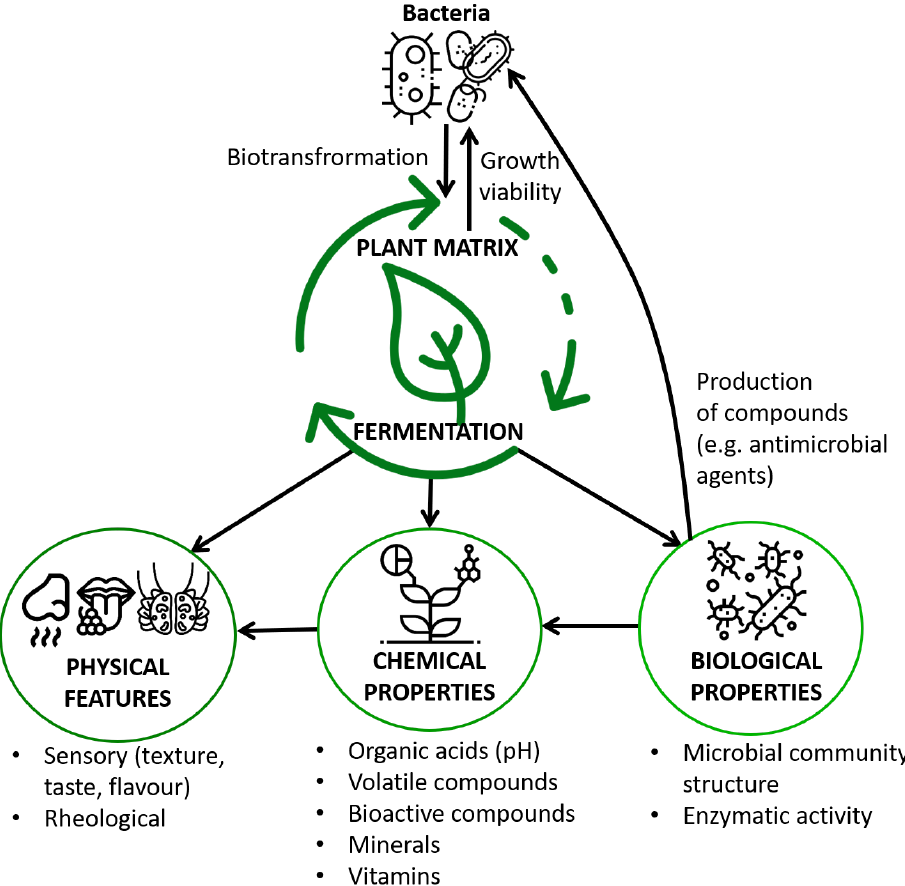
Figure 1. Fermentation as a determinant of the physical, chemical, and biological properties of plant material.